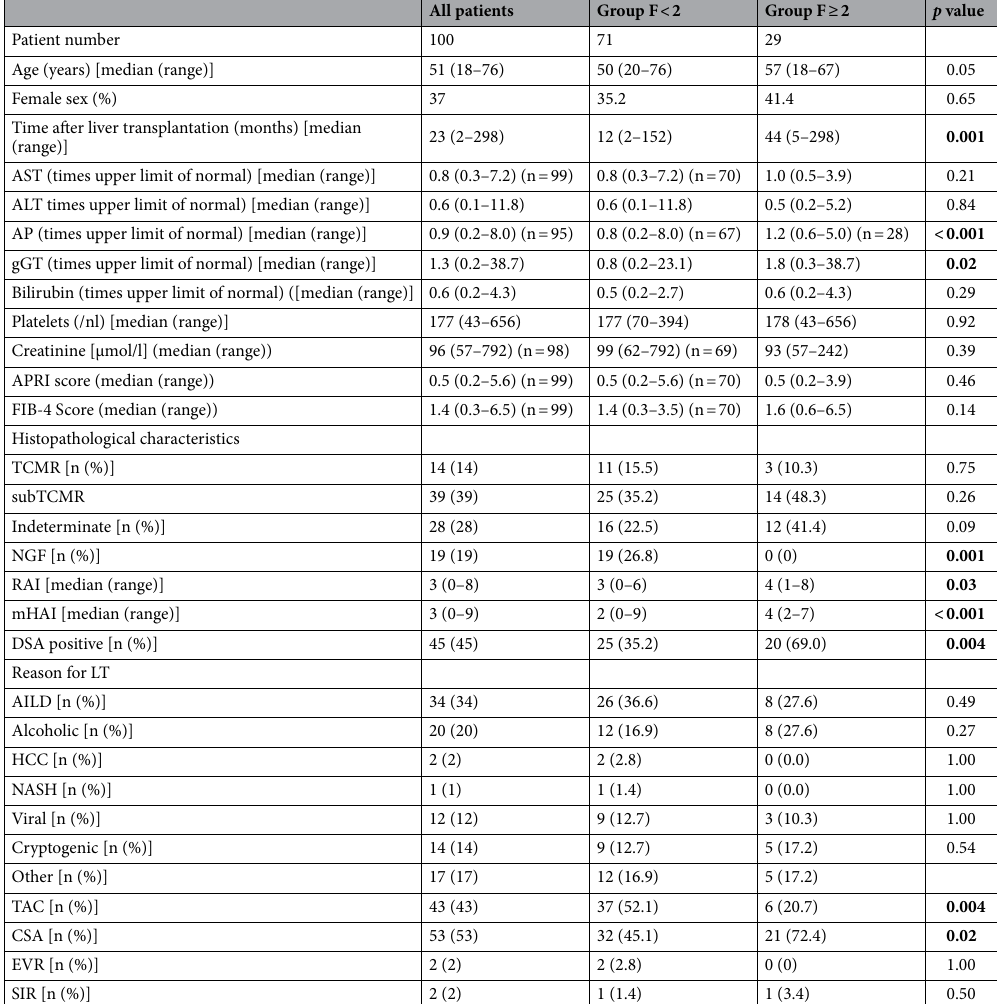
Table 1. Patients’ demographics for the overall cohort, stratified according to presence of fibrosis ≥ F2 (Ishak fibrosis staging). Significant p values for comparison between fibrosis and non-fibrosis group are designated in bold. Mann–Whitney-U Test was used for comparison of continuous variables and Fisher’s exact test was used for the comparison of categorial variables between these two groups.